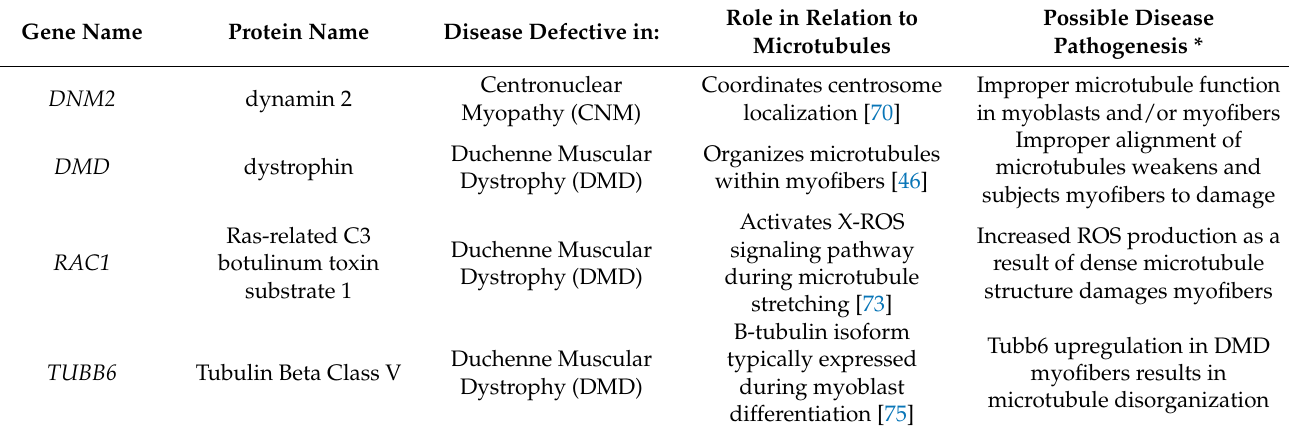
Table 1. A summary of proteins discussed that are related to the pathogenesis of myopathies. * Indicates a potential